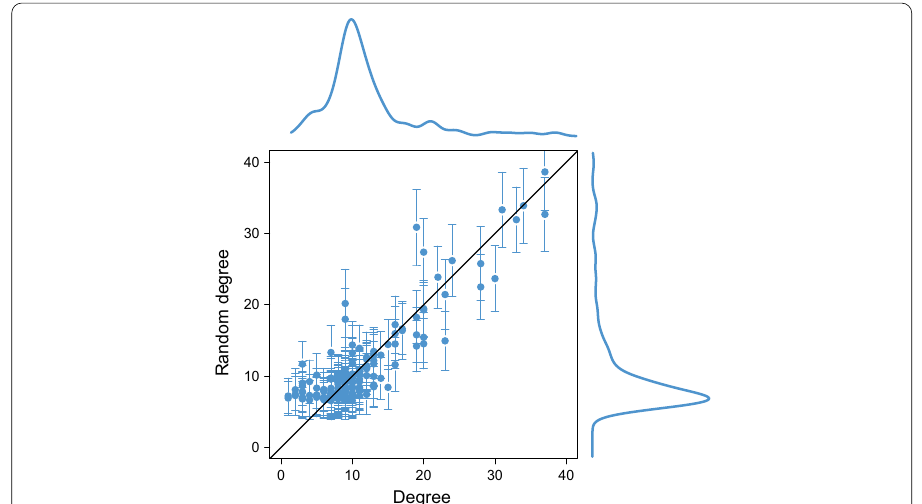
Fig. 4 Comparison between observed and average random degree distribution. Each point represents an event with the observed average degree on the x-axis and the average degree obtained with the null model on the y-axis averaged over 100 replications (the error bars represent one standard deviation). The insets show the marginal probability density distribution. We choose a representative example with the Barbel 3170. Similar plots for all fish are available in Additional file 1: Fig. S5